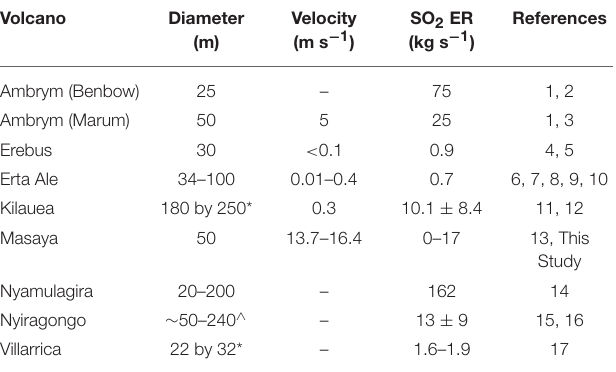
TABLE 1 | An overview of current and past lava lakes, their dimensions, lake surface velocities (where available) and degassing characteristics associated with